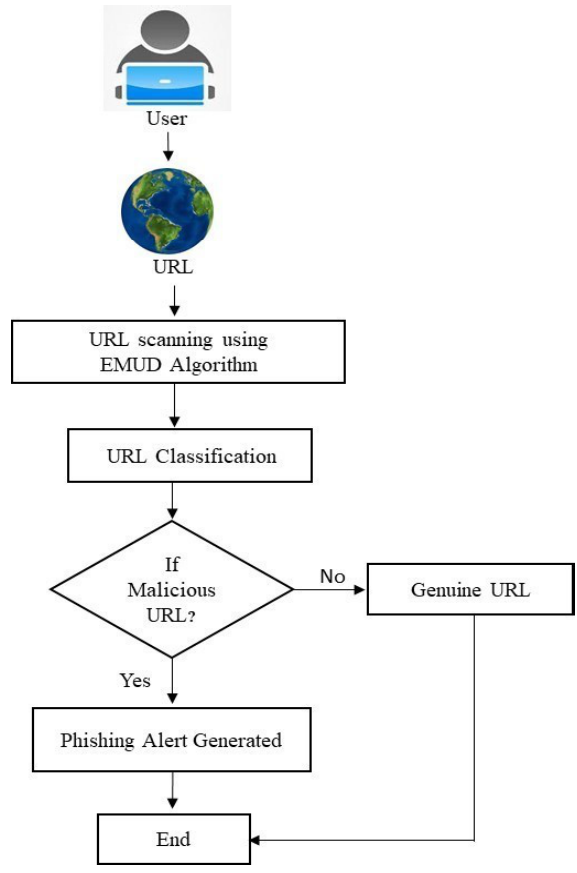
Figure 3. Architecture of Enhanced Malicious